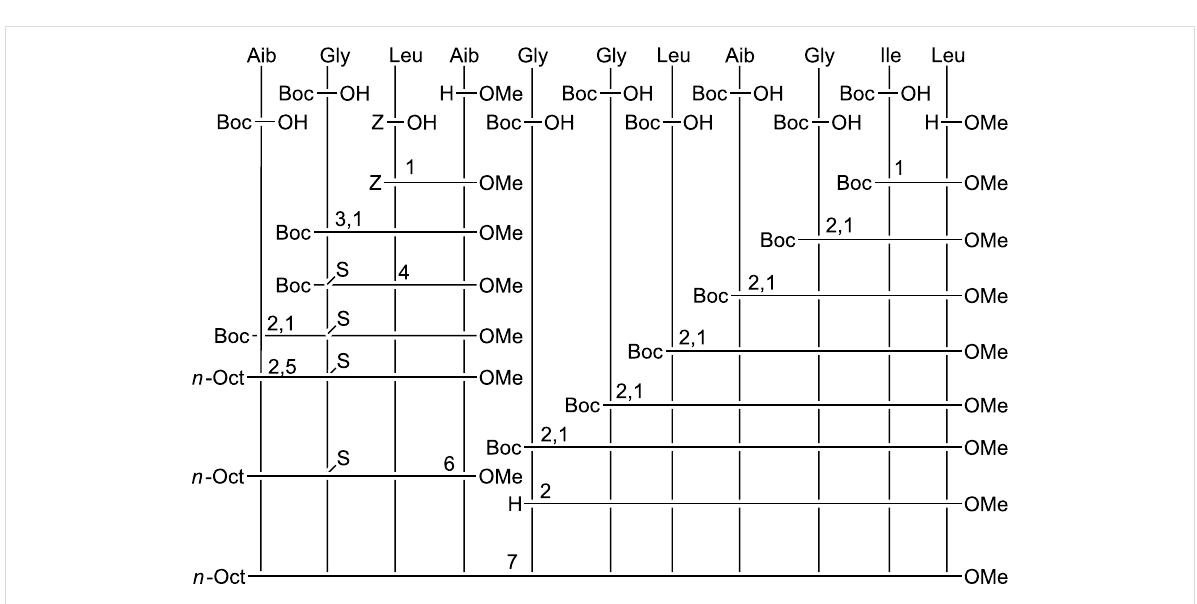
Scheme 1: Synthesis of ψ [CS-NH] 2 . 1: Coupling in the presence of EDC/HOBt. 2: Deprotection by using TFA/DCM. 3: Deprotection by catalytic hydrogenation with Pd/C. 4: Thionation with Lawesson's reagent in THF. 5: Coupling with n -Oct-OH in the presence of EDC/HOBt. 6: Saponification with NaOH/MeOH. 7: Coupling in the presence of